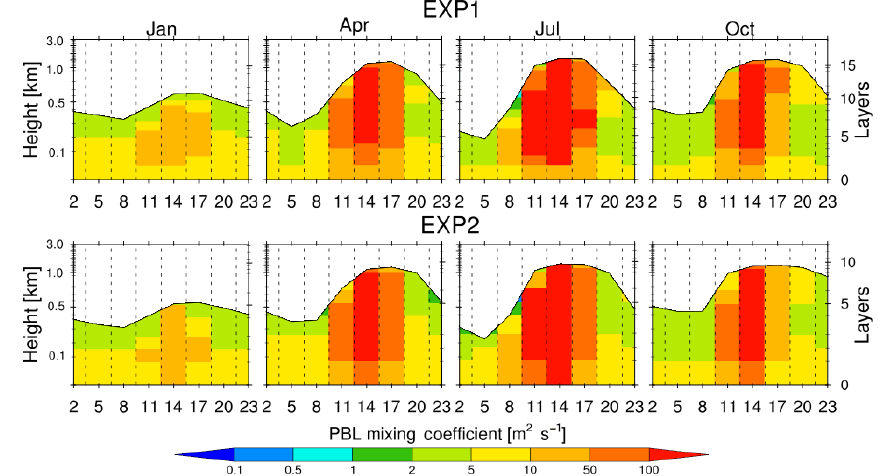
Figure 7. Diurnal variation of PBLH and PBL mixing coefficient below PBLH averaged over Hefei for January, April, July, and October of 2018 from experiments EXP1 and EXP2.